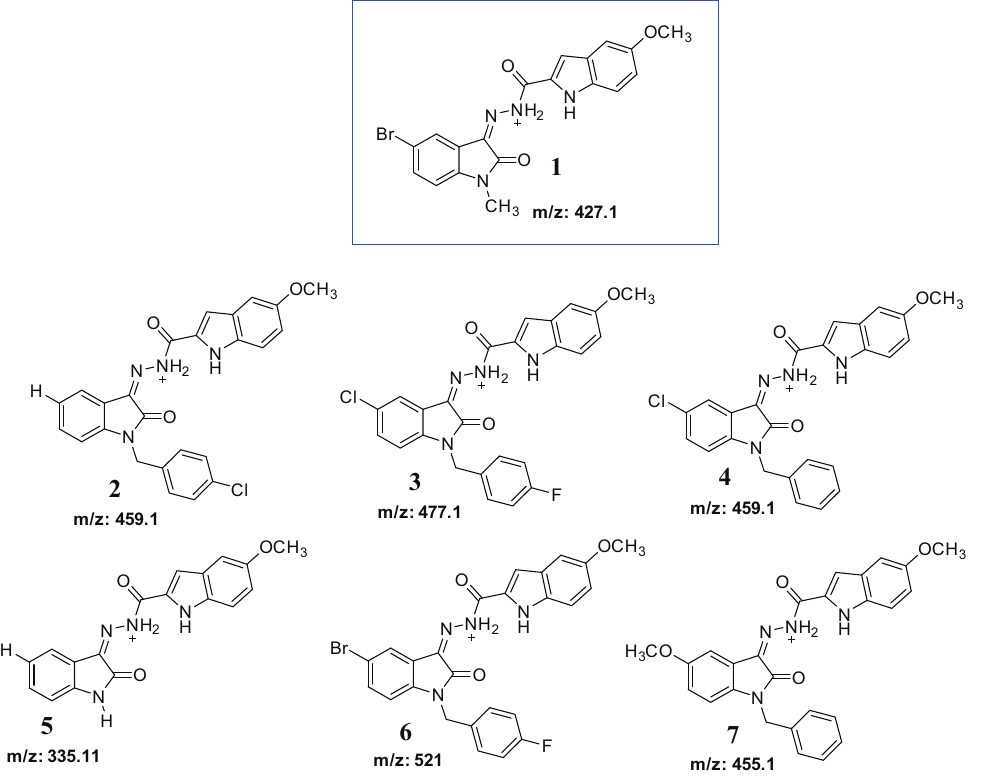
Figure 1: Chemical structures of compounds 1 – 7